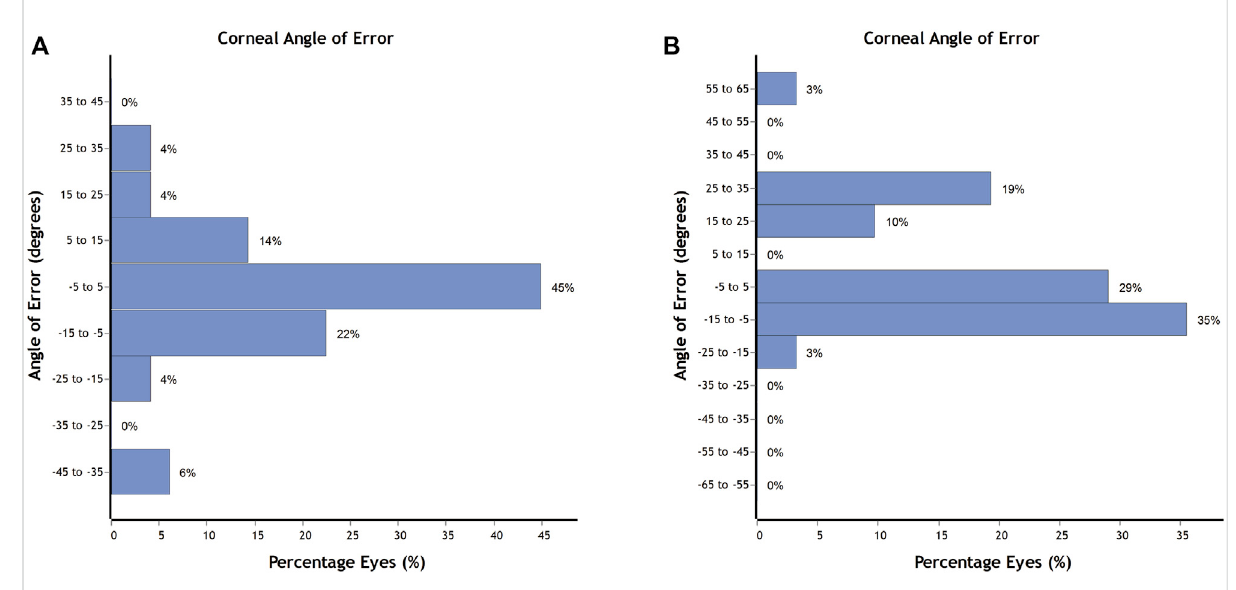
FIGURE 2 The corneal angle of error for the paired FSAK group (A) and single FSAK group (B) .